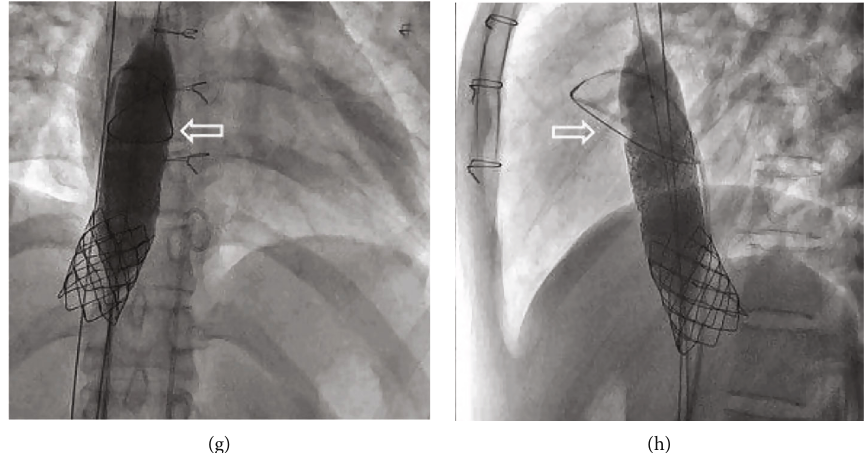
Figure 14: A 35mm Amplatz Gooseneck snare was deployed from a distal Amplatz Super Sti ff wire (a, b). The snare was used to grasp the middle of the embolized covered stent and to pull it back inside the anchored bare stent (c, d); however, we were not able to release the snare once the covered stent was back inside the bare stent (e, f). We then redeployed the snare at a more distal position and then pulled the embolized stent with balloon in fl ated in the more distal position to coaxial both stents and eventually released snare (g, h).